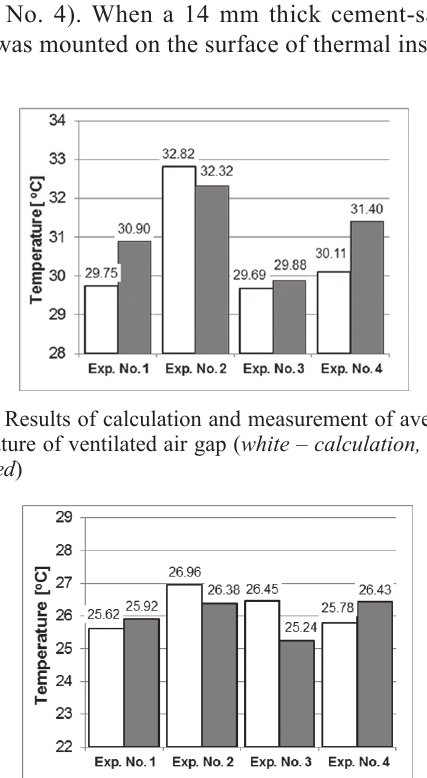
Fig. 4b. Results of calculation and measurement of average temperature of external surface of thermal insulation layer ( white – calculation, black – measured )